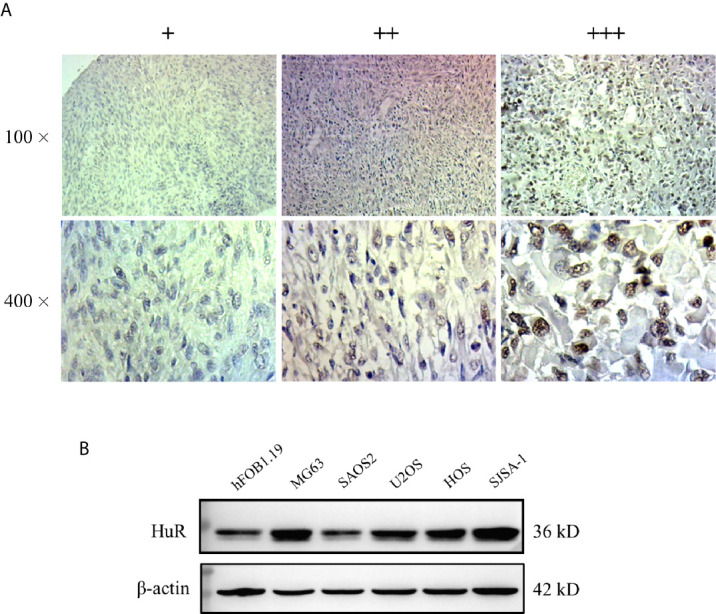
Expression of HuR protein in tissues from patients with osteosarcoma (OS) and in OS cells. (A) Representative images of different IHC staining intensities of HuR are shown in OS tissues. Staining patterns were categorized into three groups as follows: weak staining (+), moderate staining (++), and intense staining (+++). Upper panel, original magnification 100x; lower panel, original magnification 400x. (B) Western blotting analysis of HuR expression in a human osteoblast cell line (hFOB1.19) and OS cell lines (MG63, SAOS2, U2OS, HOS, and SJSA-1).